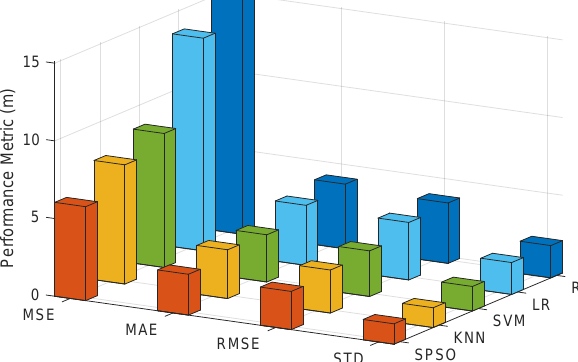
Figure 4. The MSE, MAE, RMSE and STD with different localization models.